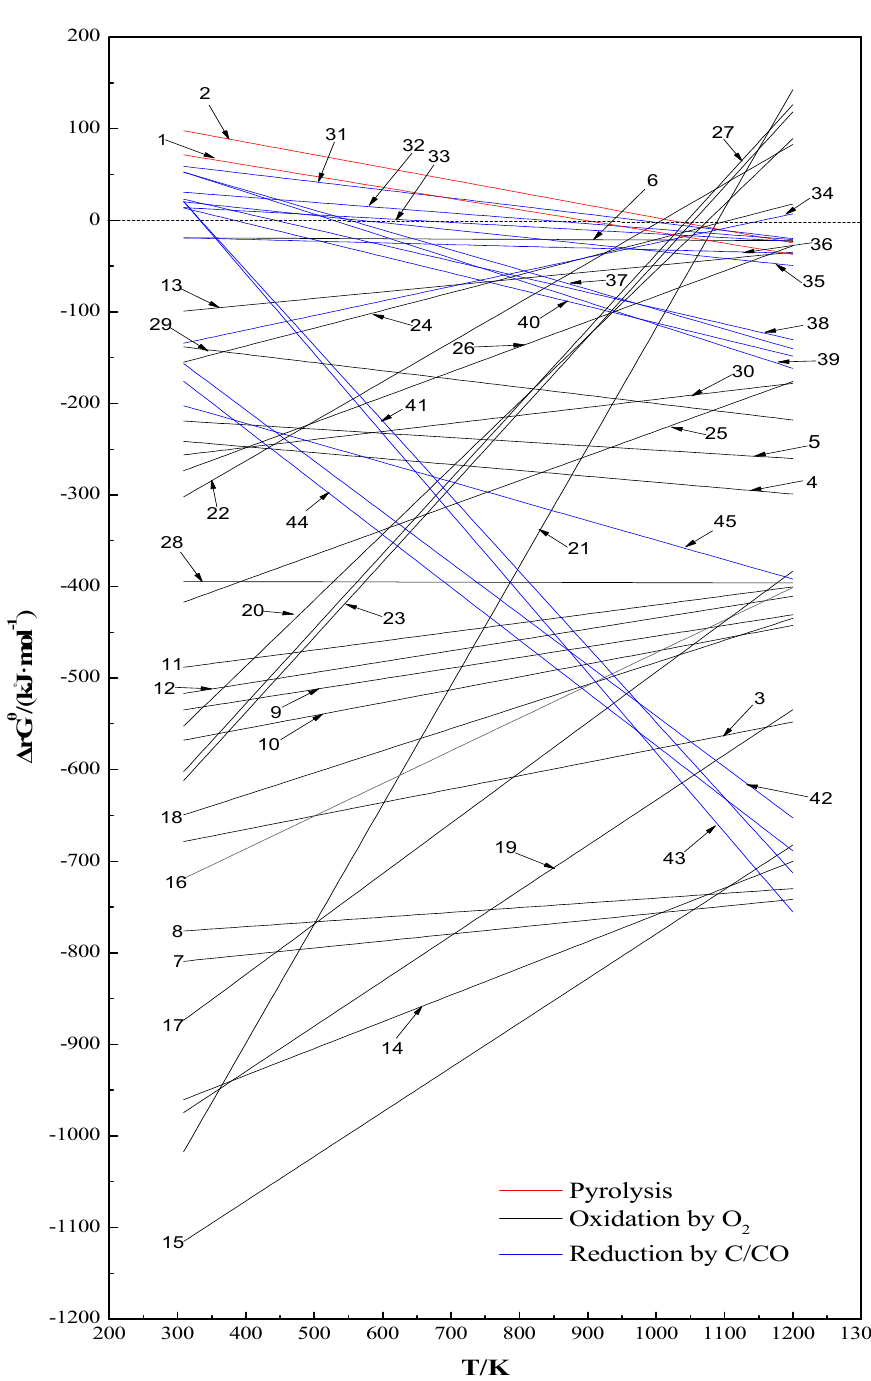
∆ θ –T (300–1200 K) relationship for possible reactions during the roasting of Figure 1. Δ r G θ –T (300–1200 K) relationship for possible reactions during the roasting of pyrite. Figure 1. r G